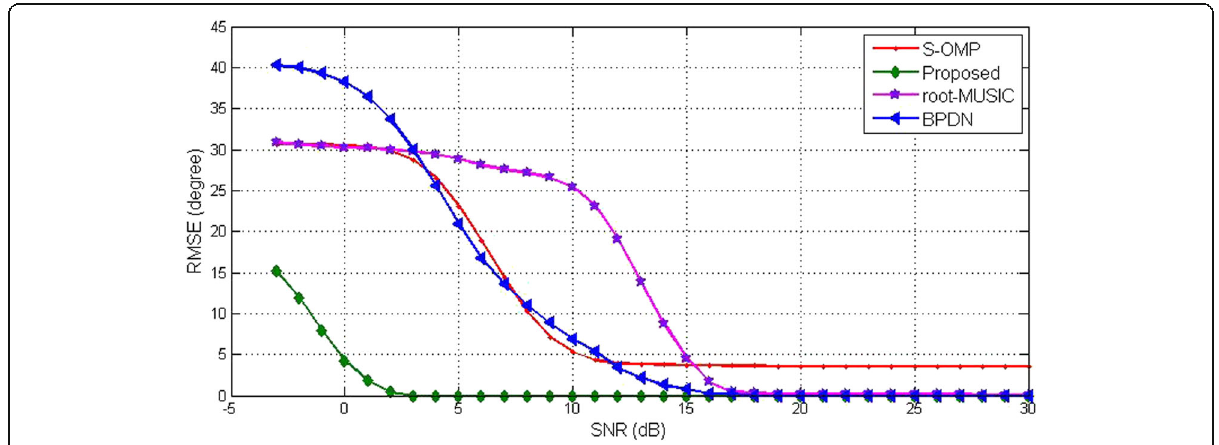
Fig. 3 Performance comparison of RMSE for DOAs at angles 10°, 70°, and